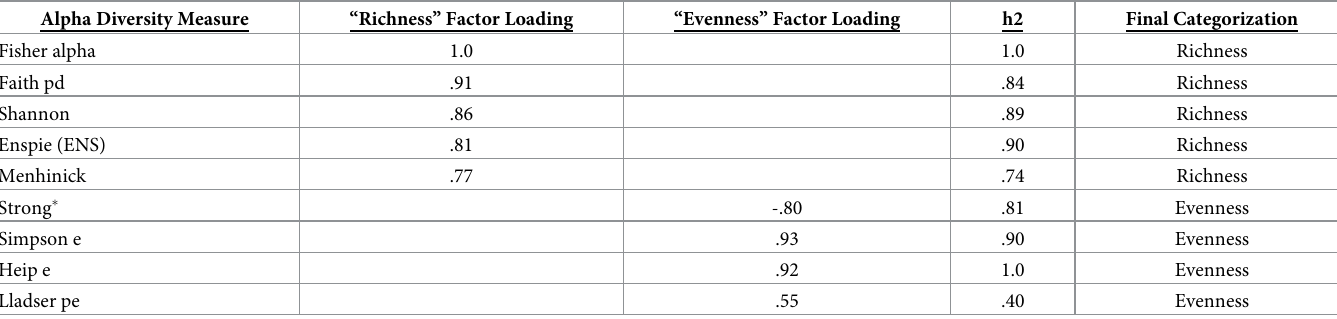
Table 4. Results of the exploratory factor